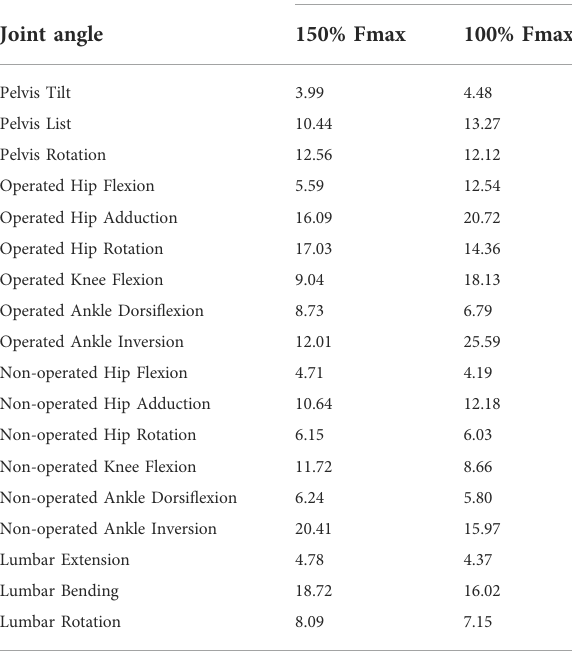
TABLE 5 Root-mean-square (RMS) differences between pre-surgery and predicted post-surgery joint angles. Percentage of Fmax indicates the percent of pre-surgery psoas peak isometric strength used to generate the post-surgery walking